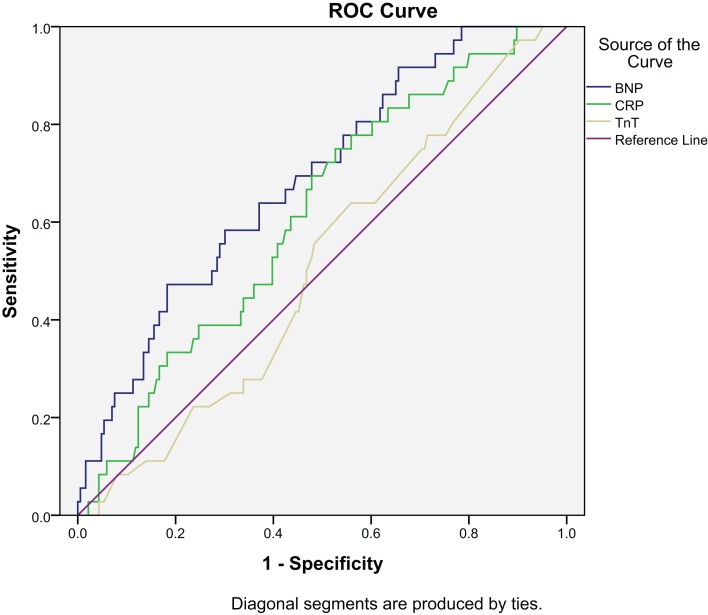
ROC for cardiac death at 2 years: BNP, CRP, and TnT.